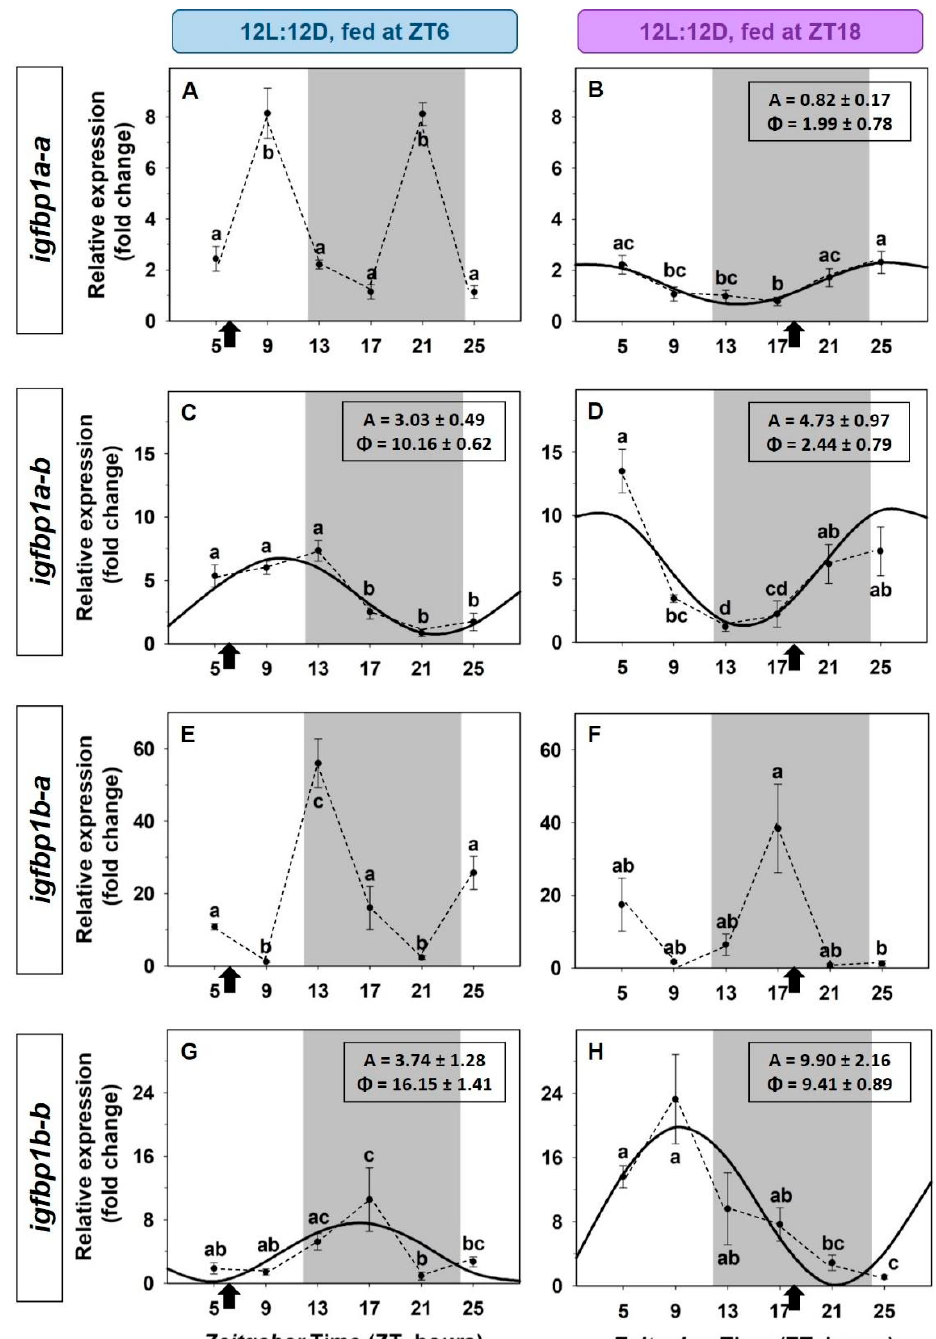
Figure 6. Effect of a shifted mealtime on the daily expression of igfbp1 paralogs in the liver of goldfish. ( A , B ) igfbp1a-a ; ( C , D ) igfbp1a-b ; ( E , F ) igfbp1b-b ; ( G , H ) igfbp1b-a . On the right ( A , C , E ), fish fed at mid-photophase, ZT6); on the left ( B , D , F ), fish fed at mid-scotophase, ZT18). Data are expressed as mean ± s.e.m. ( n = 7/sampling time). Different letters indicate statistical differences among sampling points (ANOVA). Sinusoidal curves represent significant rhythms by Cosinor analysis. Dashed lines represent significant differences among sampling points by ANOVA. Black arrows indicate feeding time. The dark period is represented in grey.